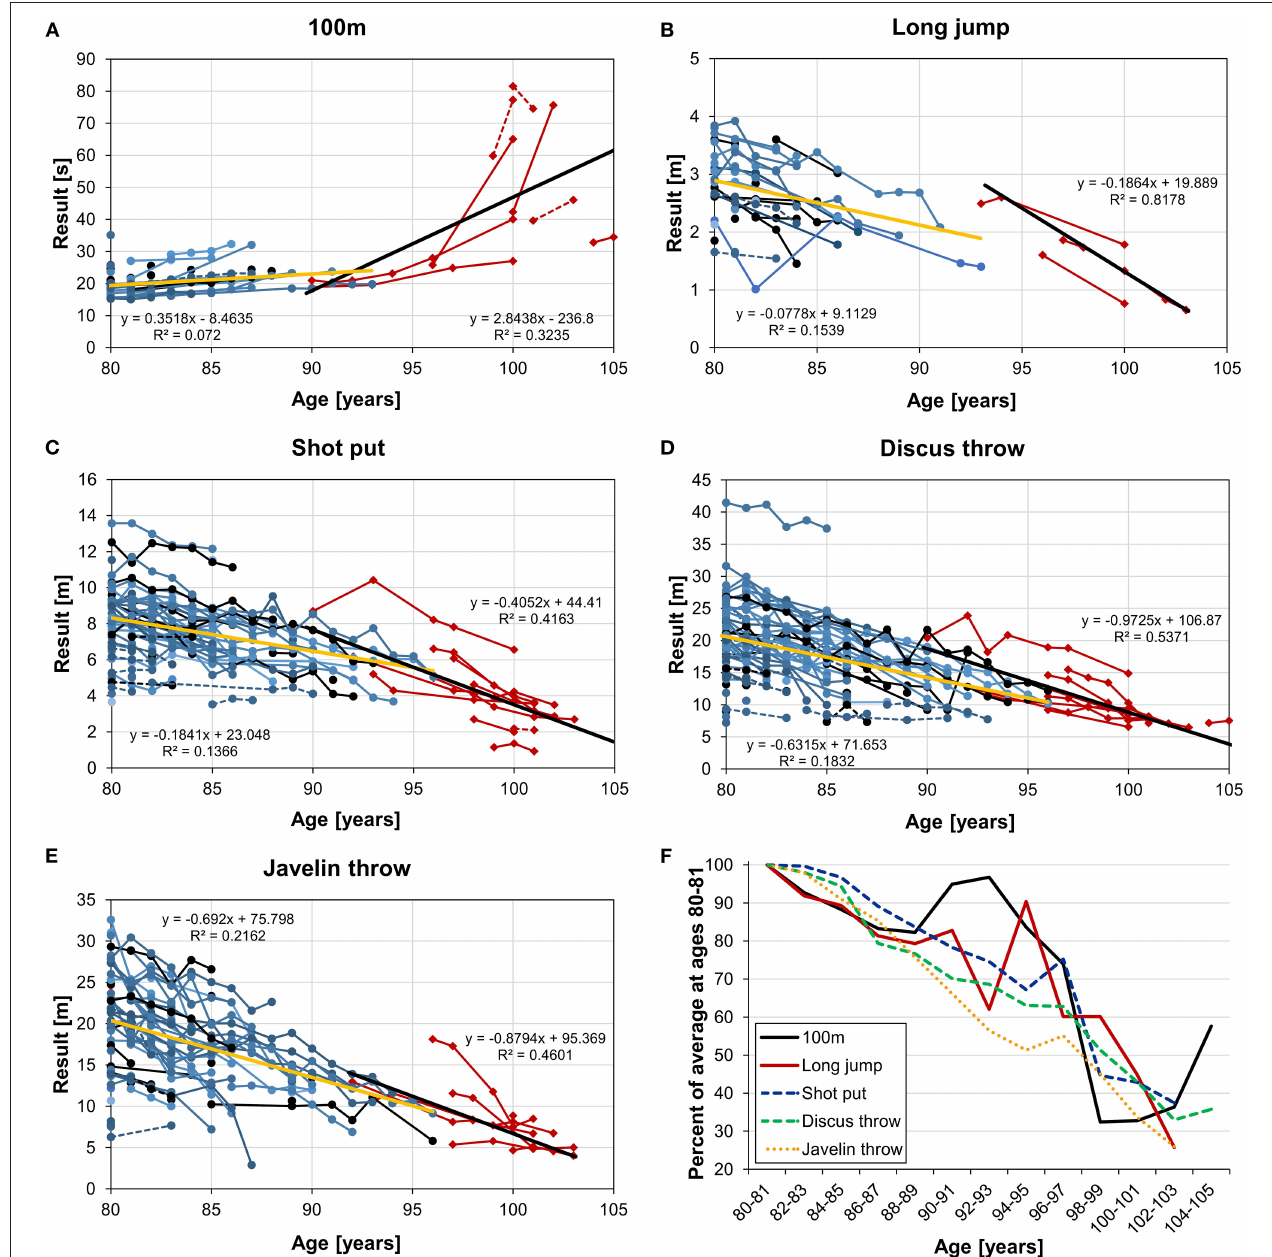
FIGURE 1 | Longitudinal decline trajectories of individual athletes for 100-m sprint (A) , long jump (B) , shot put (C) , discus throw (D) , and javelin throw (E) . Dashed lines: women; solid lines: men. Blue/black lines and circles: data from the “Swedish Veteran Athletics” data base (Ganse et al., 2020b); red lines and rhombi: data of athletes with data at age 100 and/or older. Linear regression lines and functions are shown to allow comparison with the literature. Yellow line: regression line of data from “Swedish Veteran Athletics” (80 + years); black line: regression line of the new data from the “World Master Rankings” (100 + years). (F) Direct comparison of the performance declines normalized to ages 80–81 in the five disciplines, shown in pooled 2-year